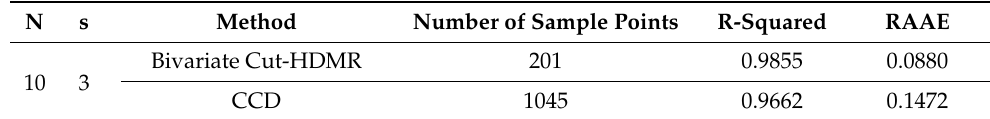
Table 5. Performance metrics of Bivariate Cut-HDMR and CCD.